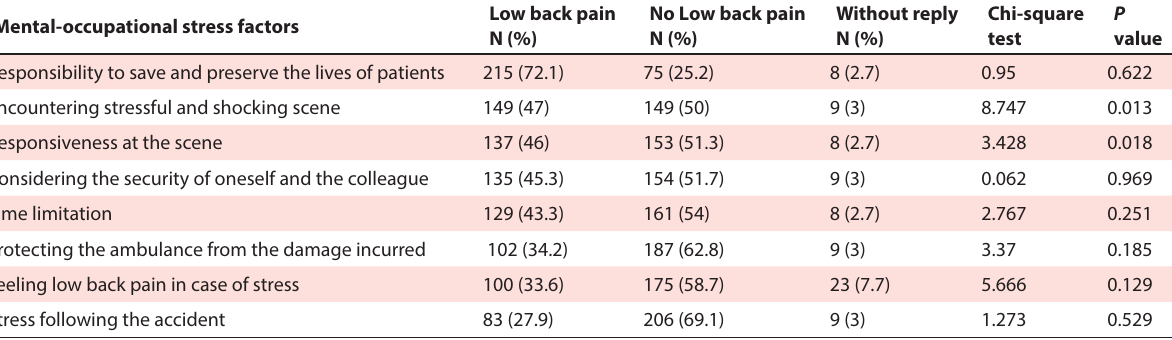
Table 3. Frequency distribution of mental-occupational factors in the pre-hospital emergency personnel and its relationship with low back pain Mental-occupational stress factors